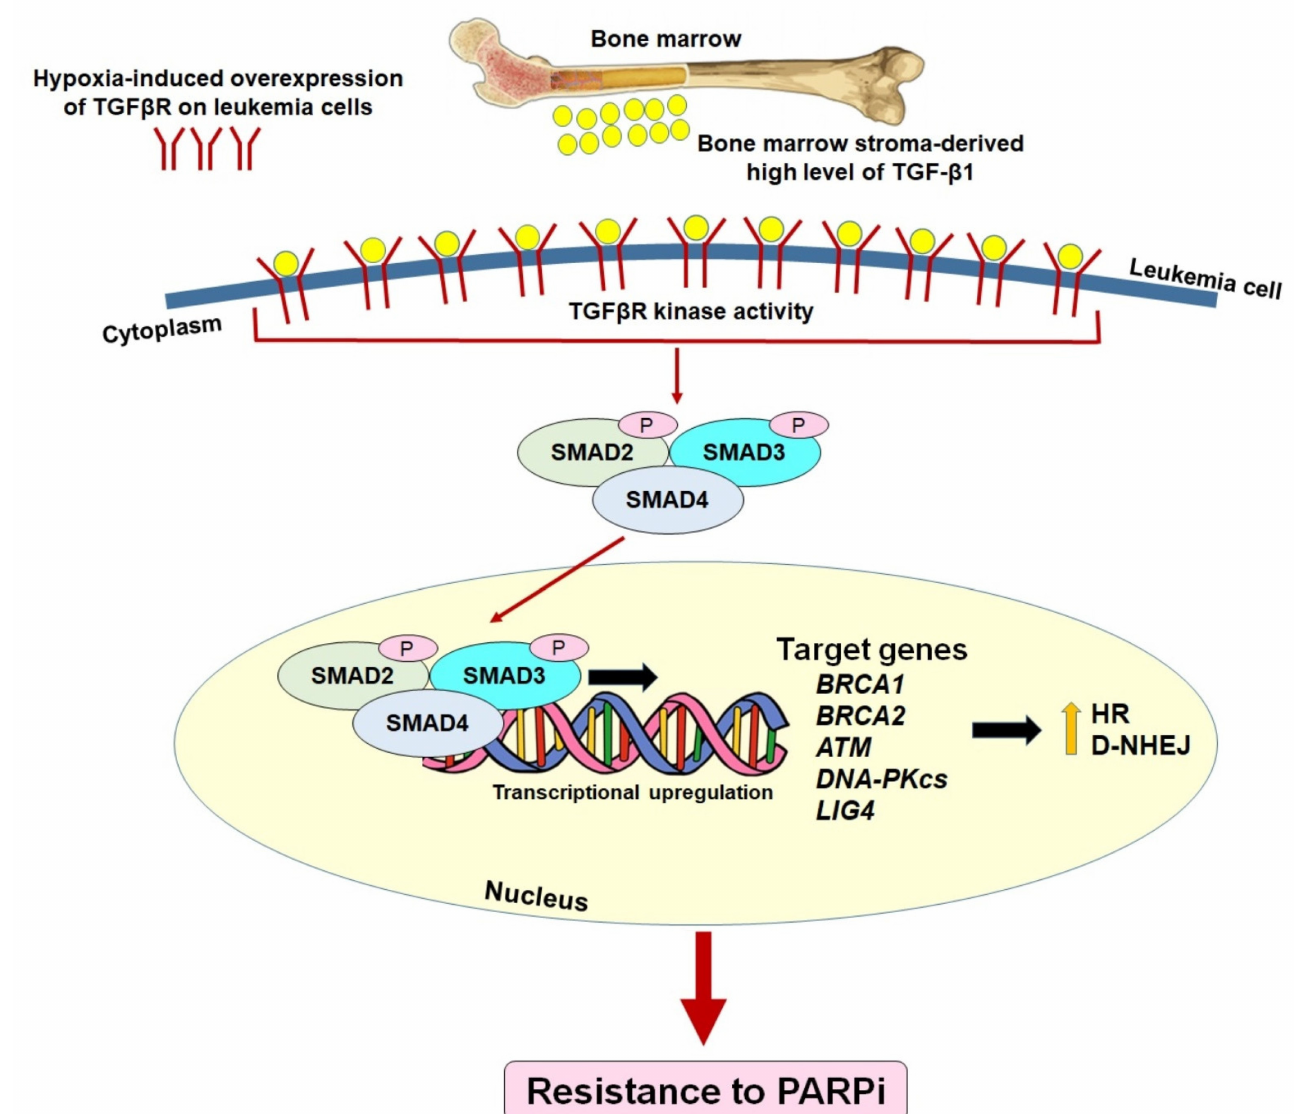
Figure 3. Pre-existing mechanism of PARP inhibitor resistance by the restoration of HR/c-NHEJ in HR/c-NHEJ-deficient leukemias via the activation of TGF- β 1—TGF β R—SMAD2/3 signaling in the hypoxic bone marrow